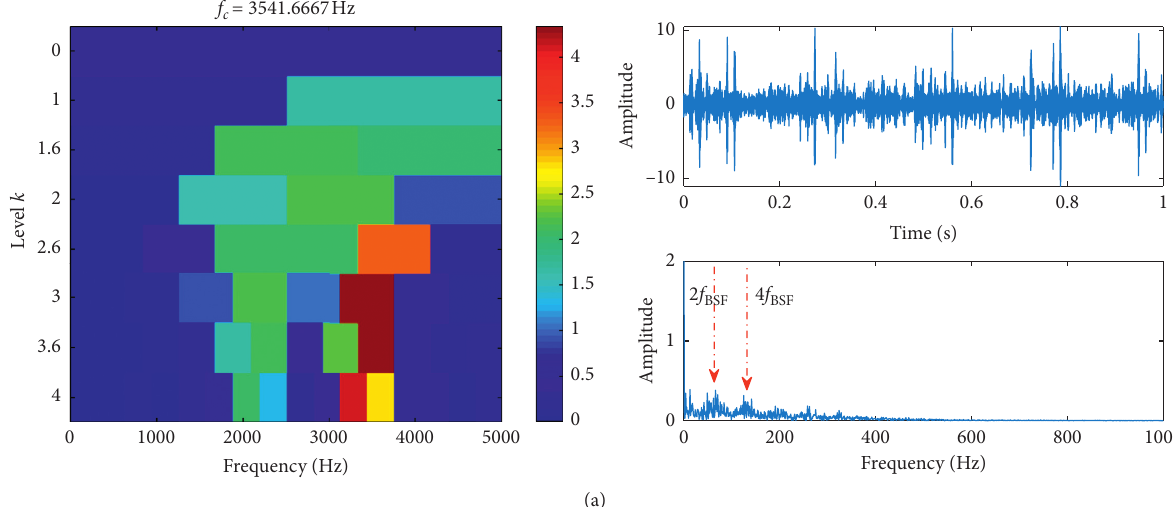
Figure 32: Spectral kurtosis for identification of wheelset bearing roller fault. (a) Fast Kurtogram; (b) filtered signal; and (c) envelope spectrum of signal in Figure